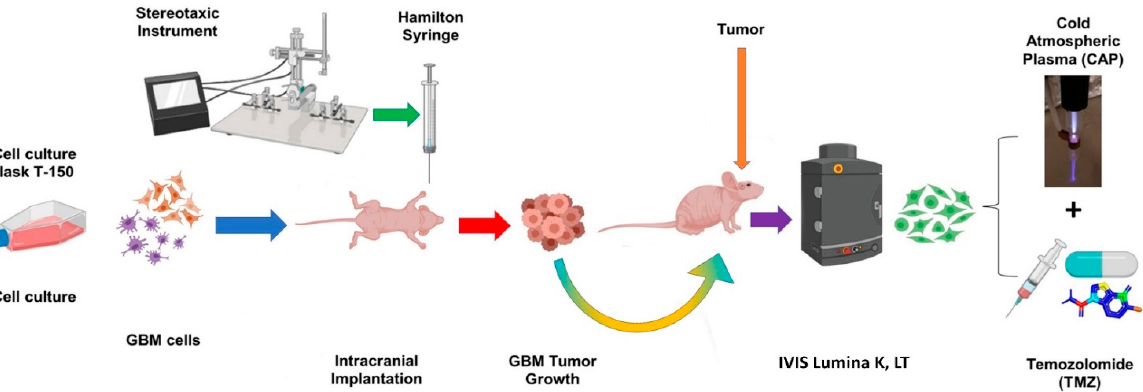
Figure 8. Schematic representation of in vivo CAP targeting plus TMZ treatment of intracranial GBM tumors in nude mice.